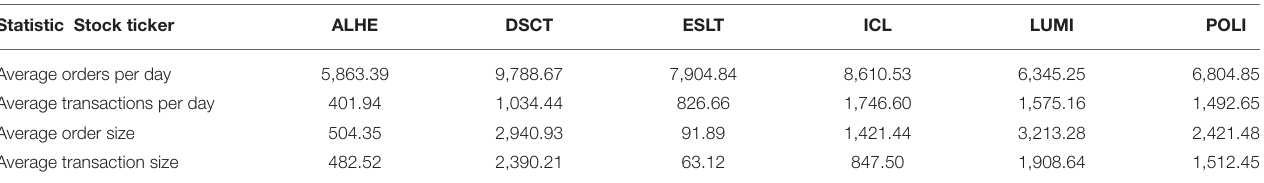
TABLE 1 | Statistical